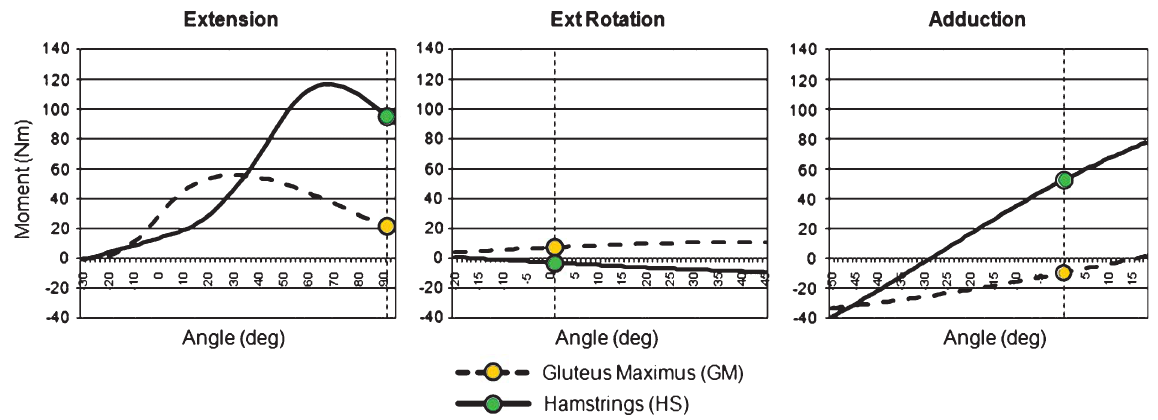
Fig. 3. Comparing extension, external rotation and adduction moments for GM stimulation and HS stimulation: GM moments (circles on dashed lines) are all of a similar order of magnitude at the angles of interest for neutral, seated posture (extension 21.7Nm; external rotation 7.1Nm; abduction 9.9Nm). For HS moments (circles on solid lines), however, the extension torque (97.3Nm) dominates that for external rotation ( − 2.6Nm). The moderate adduction component (52.2Nm) is of less concern as it will be stopped in the midline by the contralateral limb or a commercial spacer if